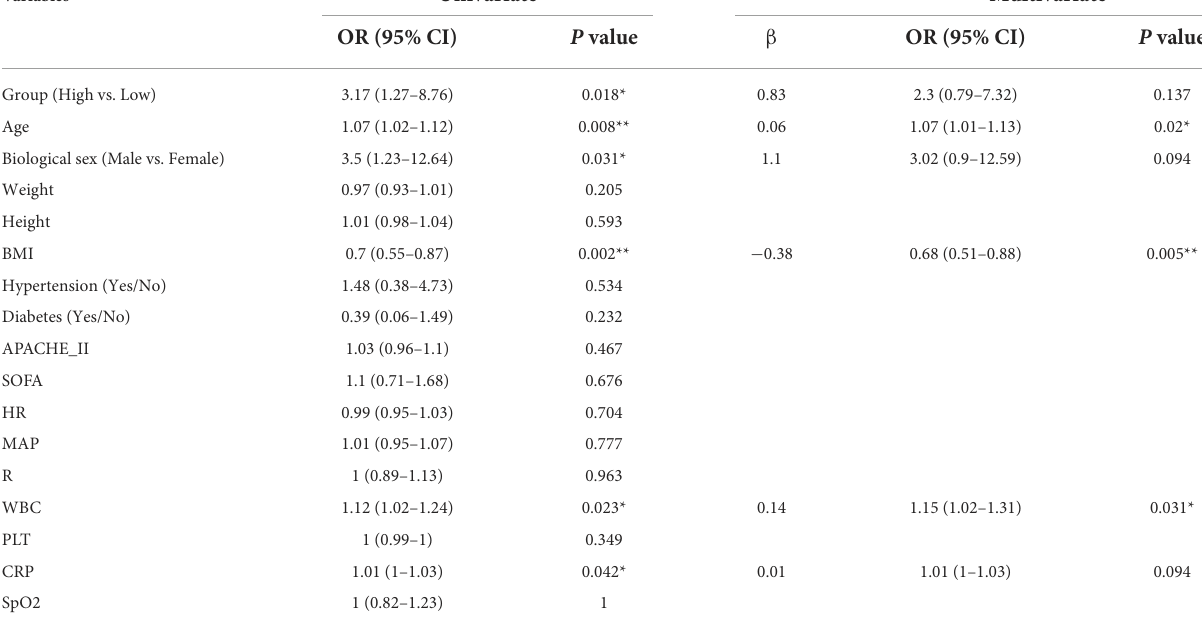
TABLE 4 Univariate and multivariate logistics regression analysis.